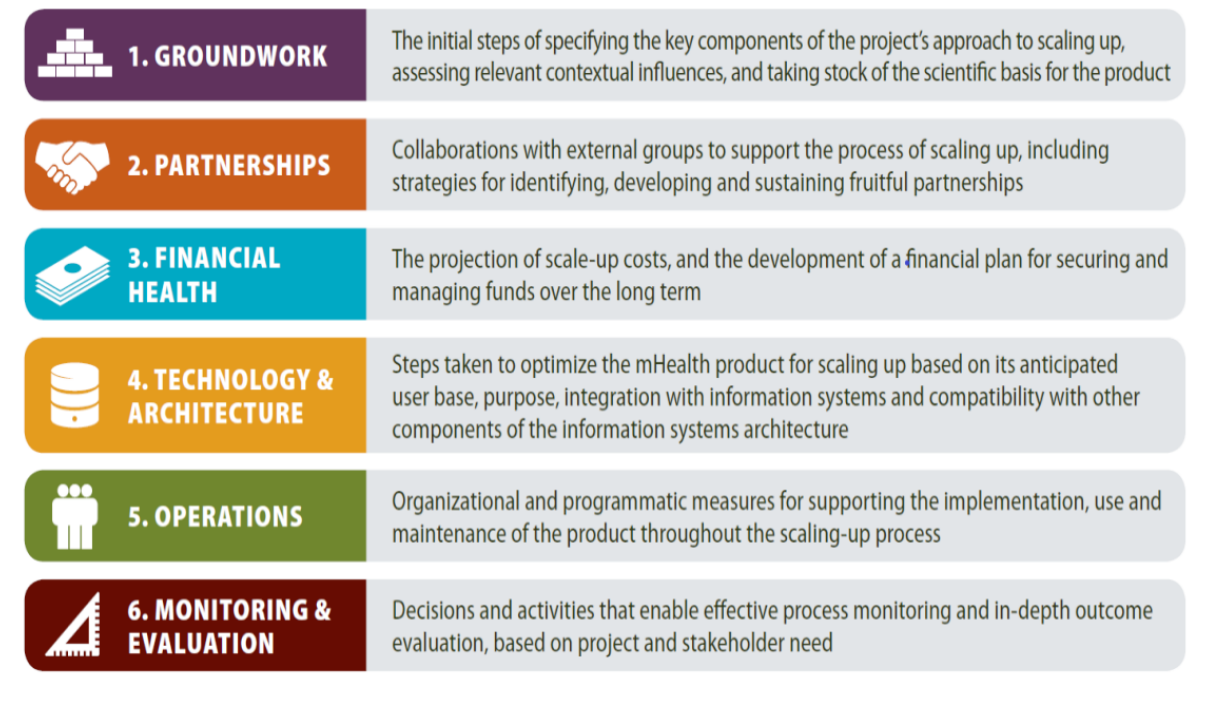
Figure 2. The mHealth Assessment and Planning for Scale Toolkit drivers of success within each axis of scale